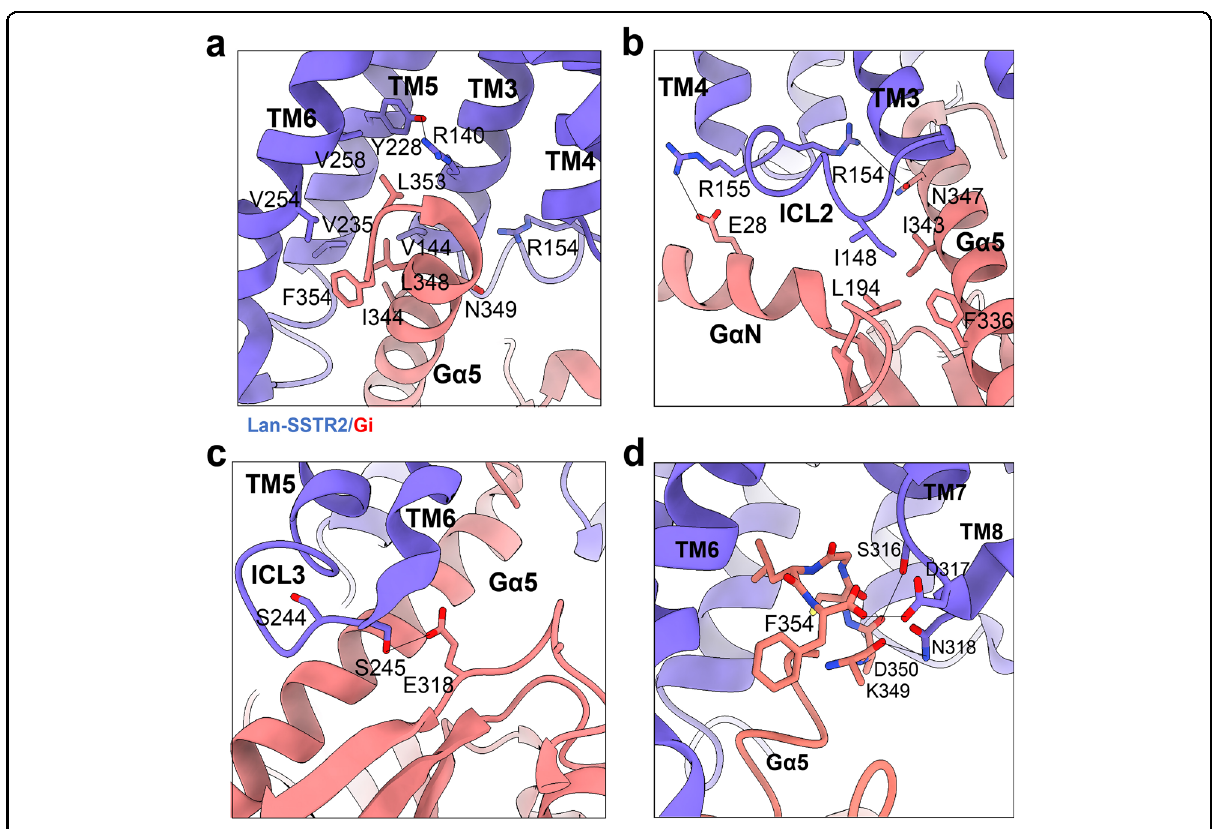
Fig. 4 Interaction interfaces between the SSTR2 and Gi protein in the presence of lanreotide. a The network of interactions between lanreotide-bound SSTR2 (purple) and α 5 helix of Gi (salmon). b The ICL2 – Gi interface of lanreotide-bound SSTR2 (purple) and Gi (salmon). c The ICL3 – Gi interface of lanreotide-bound SSTR2 (purple) and Gi (salmon). d The TM7 – TM8 loop and α 5 helix interface of lanreotide-bound SSTR2 (purple) and Gi